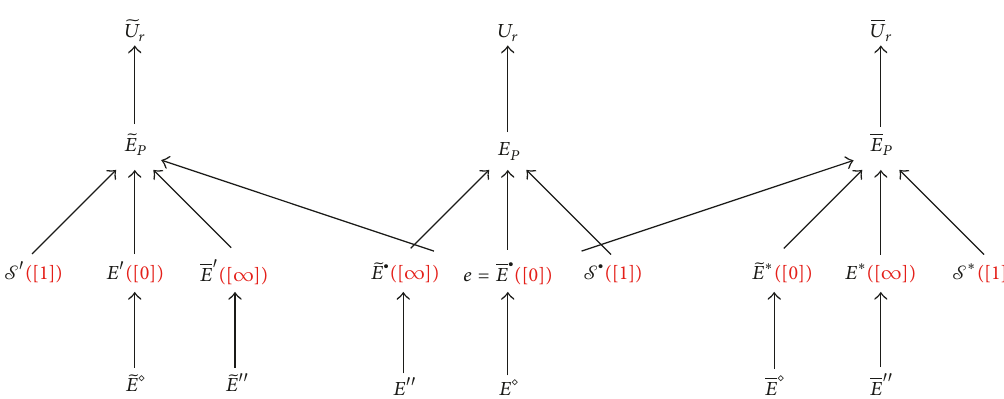
∙ ̃ E ch whenever 𝑒 = 𝐸